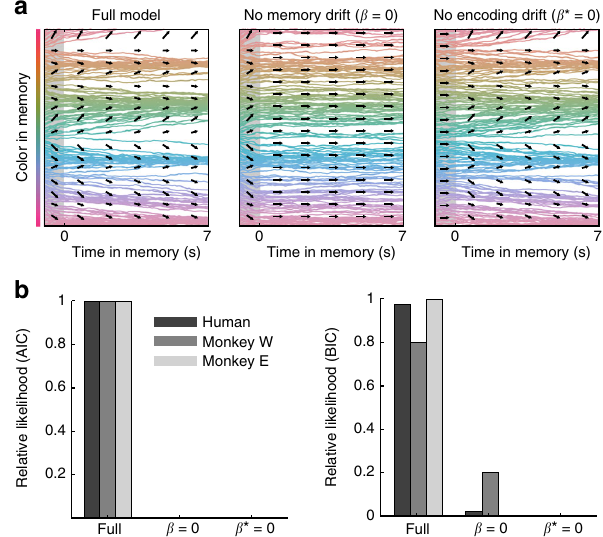
Fig. 3 Behavior is best explained by attractor dynamics during encoding and memory. a Simulated memory trajectories from the best- fi tting model for one subject. Left: The full dynamical model includes drift towards attractor states during both encoding and memory. Reduced models include drift only during encoding (middle) or memory (right). b AIC and BIC model weights (normalized relative likelihood) for the full model compared with models with zero drift during encoding ( β * = 0) and memory ( β = 0). Values indicate the probability that the given model is the best model in the set 49 . Source data are provided as a Source Data fi clockwise drift (to the right in Fig. 2b) while negative values re fl ect a counterclockwise drift (to the left). Thus, attractors are points in mnemonic space that 1) are fi xed, such that they have no drift, and 2) pull nearby memories towards themselves, indicated by a negative slope in the drift function (Fig. 2b, dashed lines). Subjects displayed the same number and location of clusters in their distribution of memory reports regardless of load condition (Supplementary Fig. 2), so we assumed that the pattern of drift did not vary with load (i.e., the shape of the function G ( θ ) was the same across loads). However, as with diffusion, the strength of the drift was allowed to vary across memory load (i.e.